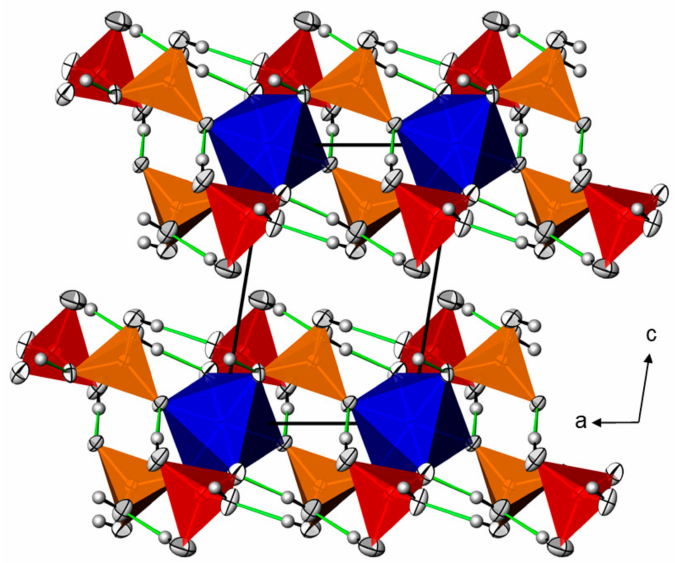
Figure 1. Representative for the M (H 2 X O 4 ) 2 (H 3 X O 4 ) 2 series, the crystal structure of Mn(H 2 AsO 4 ) 2 (H 3 AsO 4 ) 2 is given in a projection along (010). Displacement ellipsoids are drawn at the 90% probability level. H 2 AsO 4– tetrahedra (As2) are orange, H 3 AsO 4 tetrahedra (As1) are red, MnO 6 octahedra are blue; H atoms are displayed as grey spheres of arbitrary radius. O ··· H hydrogen bonds are shown as green